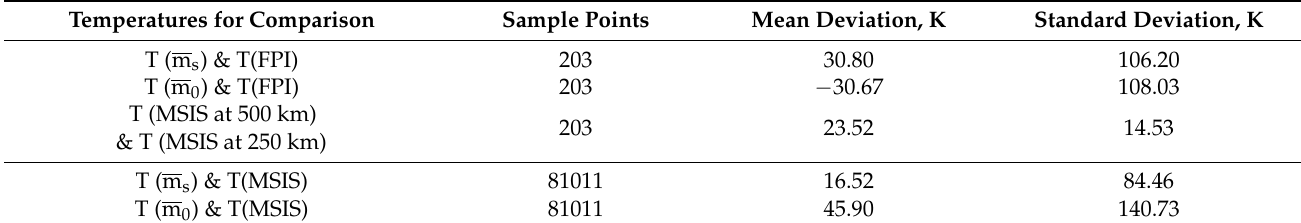
Table 2. Comparative statistical analysis of inversion temperatures calculated with m 0 and m s , FPI temperatures and MSIS